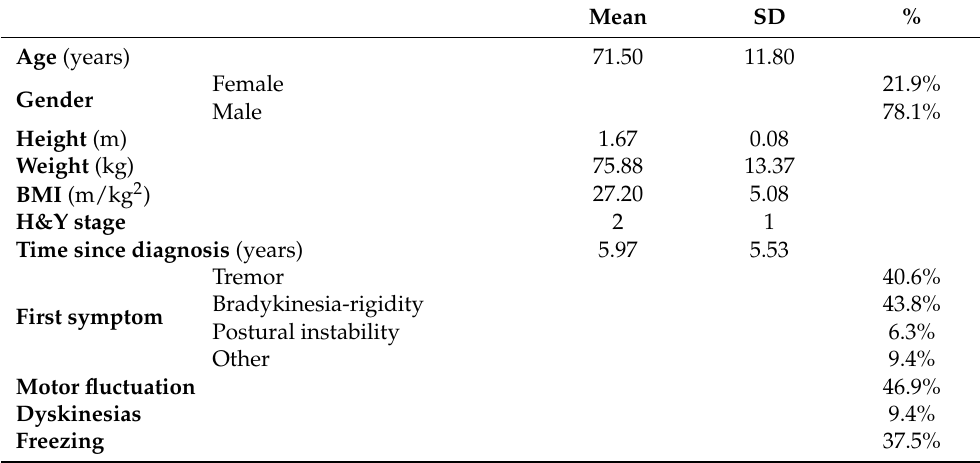
Table 1. Demographic and clinical characteristics of the patients (n =